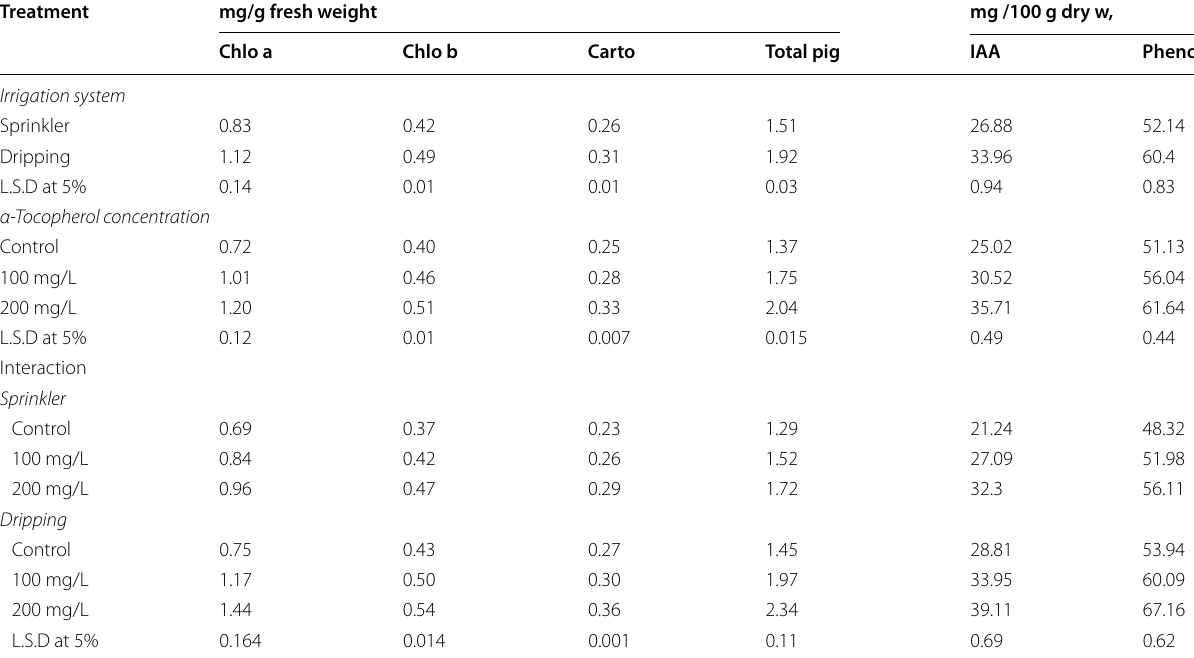
Table 3 Effect of irrigation system and α-tocopherol foliar spray on photosynthetic pigments, indole acetic acid (IAA) and phenol contents of leaves and shoots of sweet corn plant grown under sandy soil conditions